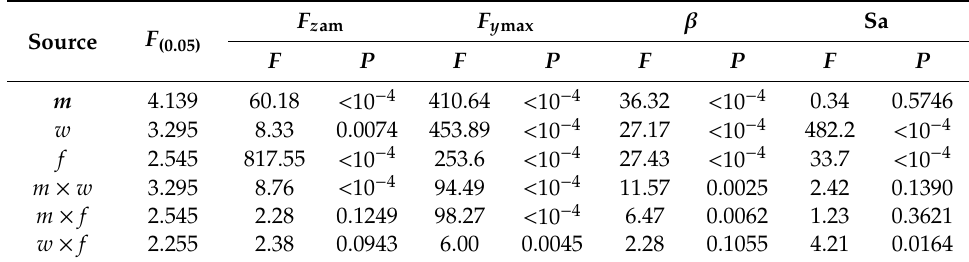
Table 4. Significance analysis of process parameters to